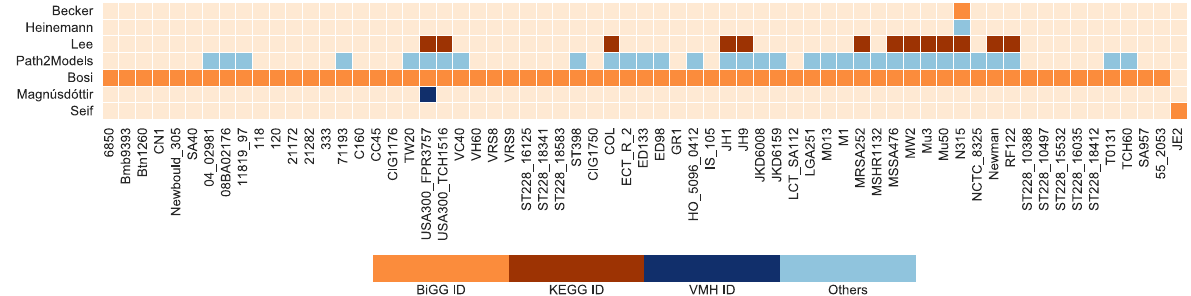
Fig. 2 Occurrence of models for S. aureus strains. Sixty- fi ve different strains of S. aureus are available over the seven publications. Some S. aureus strains, such as the S. aureus strain USA300-FPR3757, occur in several publications, for other strains, only one publication is available. The colors indicate the utilized metabolite and reaction identi fi ers in the respective models. Models with similar or same identi fi ers can be compared more